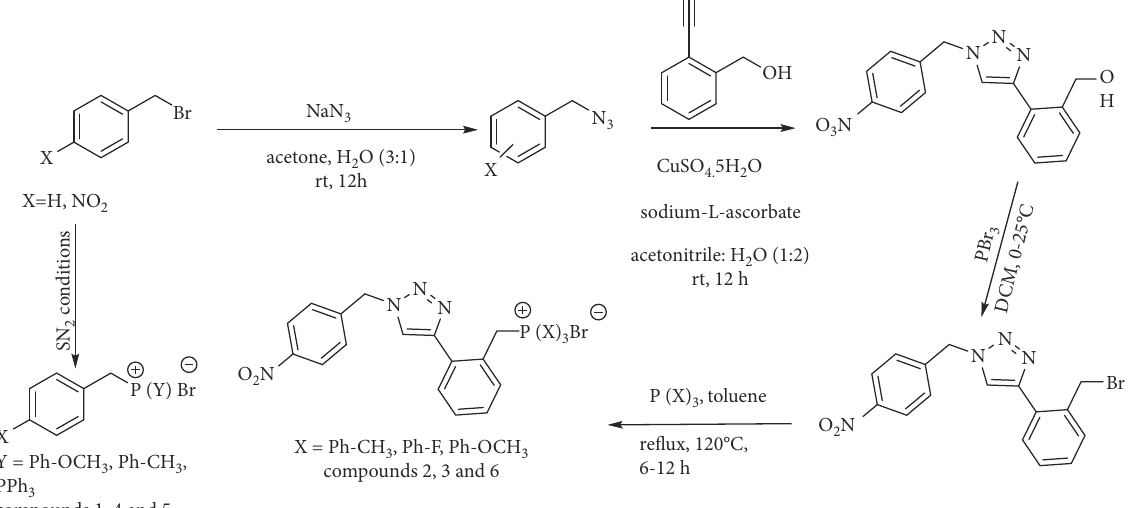
3 (P-MEOXY), Ph-CH 3 (RABYL-